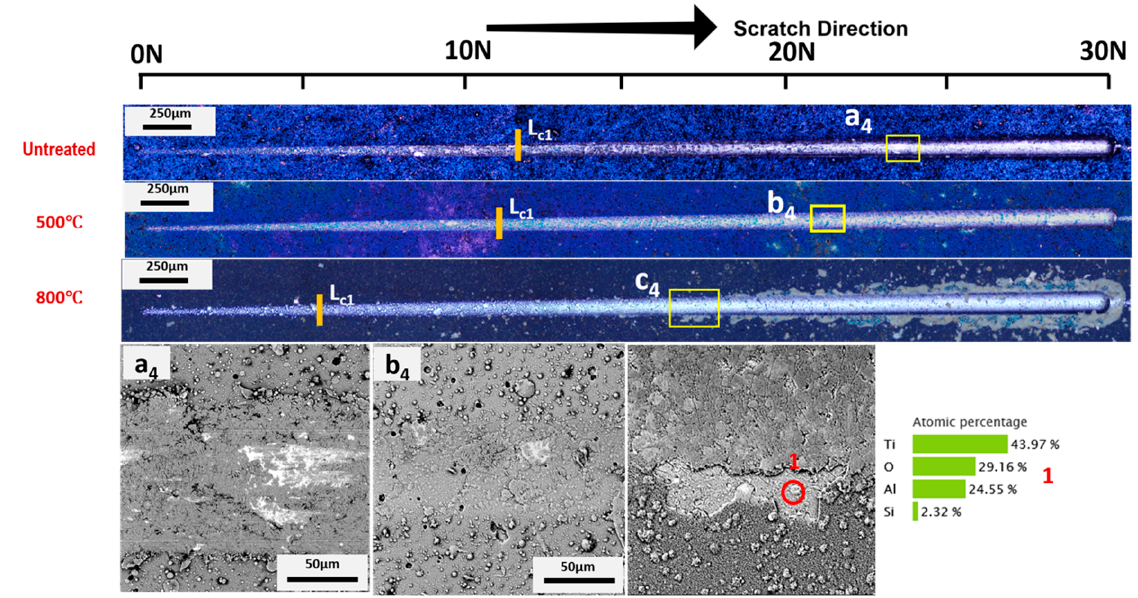
Figure 8. Adhesion optical profile and SEM images of failure and EDX analysis after microscratch tests of the AlTiSiN/Inconel sample. First ( L c1 ) critical loads are indicated. SEM magnification of selected areas (a 4 , b 4 and c 4 ) are also presented as well as the chemical compostion by EDX of the indicated point.